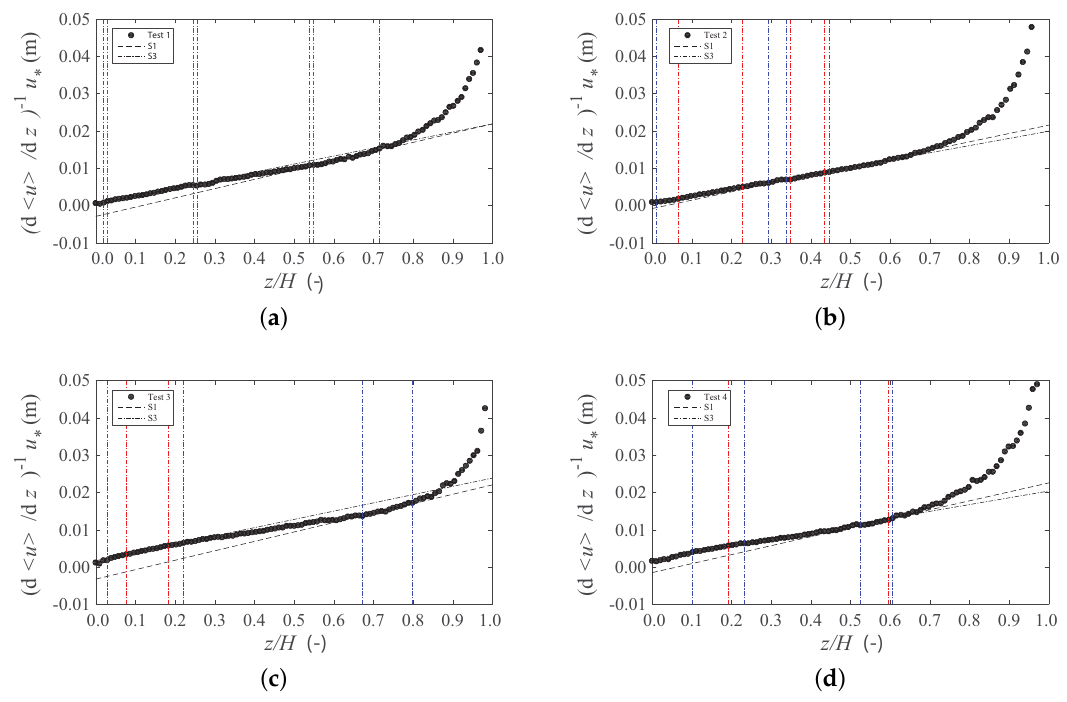
Figure 4. Shear rate and two-linear reaches identified respectively for Test 1 ( a ); Test 2 ( b ); Test 3 ( c ); Test 4 ( d ). The regression lines are represented by dashed and dotted lines (as identified in the legend). The bounds of the regression analysis that maximize the determination coefficient are marked with vertical red dashed lines. Blue lines represent the bounds associated with the minimum admissible coefficient of determination—98% of the maximum coefficient of